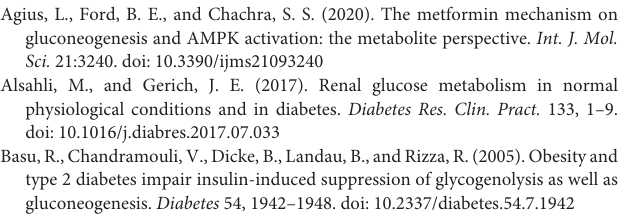
Supplementary Figure 1 | Effects of empagliflozin on urinary glucose excretion and fasting blood glucose. (A) Urine glucose excretion. (B) Fasting blood glucose